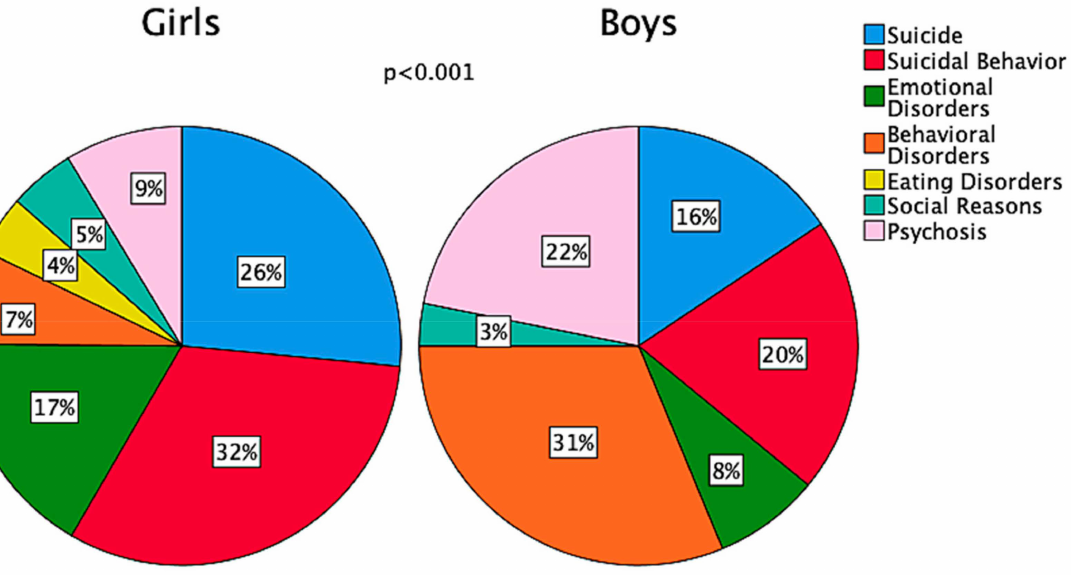
Figure 2. Sex-related distribution of reasons for admission to the Pediatric Psychiatric Clinic during the study